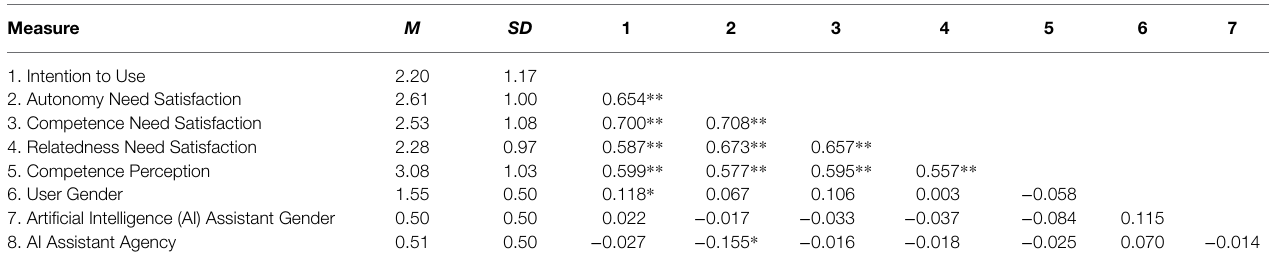
TABLE 1 | Spearman’s correlations between the dependent